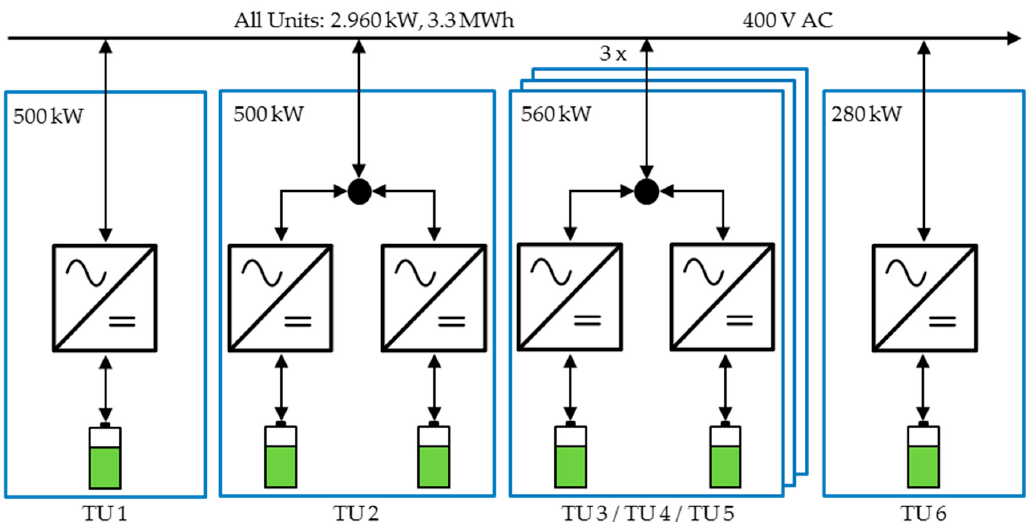
Figure 3. Overview of all Technical Units.